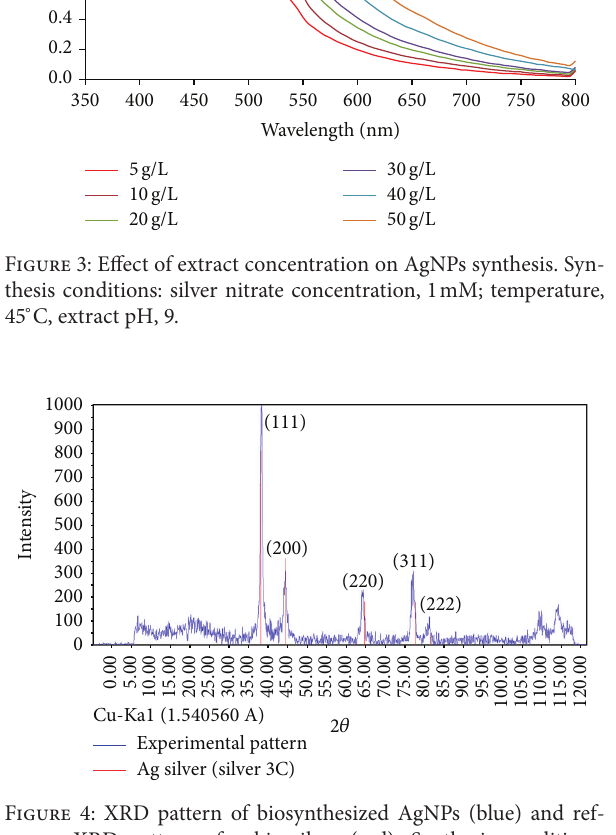
Figure 2: Effect of temperature on AgNPs synthesis. Synthesis con- ditions: silver nitrate concentration, 1mM; extract concentration; 40 g/L, extract pH, 9.